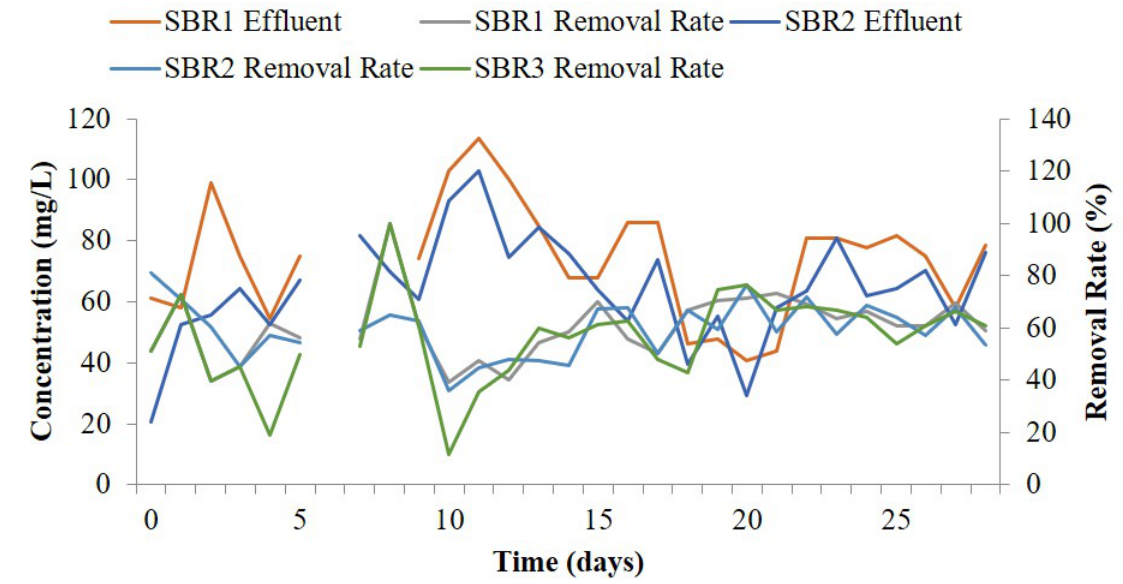
Figure 4. SBR treatment performance during start-up